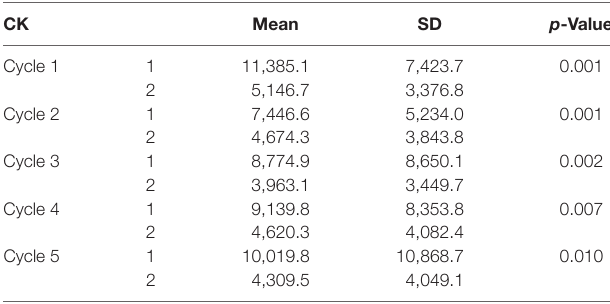
TablE 2 | Changes in creatine kinase (CK) activity in 19 patients in ambulant and non-ambulant patients with Duchenne muscular dystrophy in each cycle of treatment.